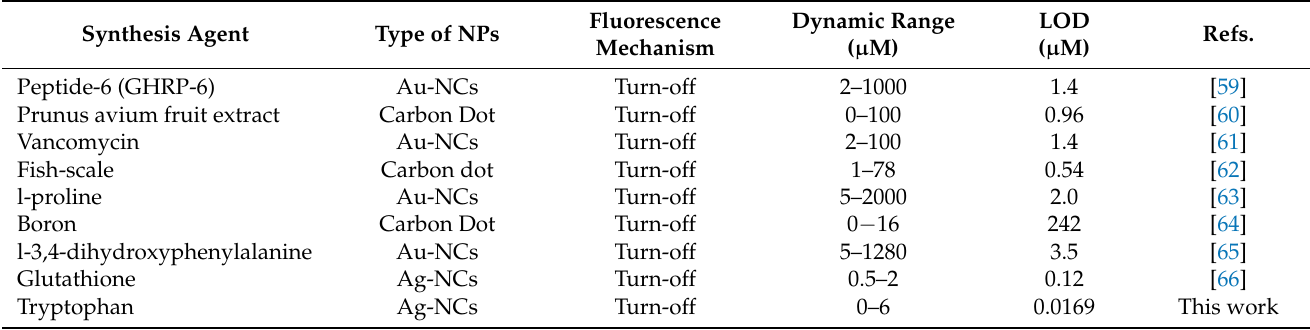
Table 2. Recent optical sensors for ferric ions’